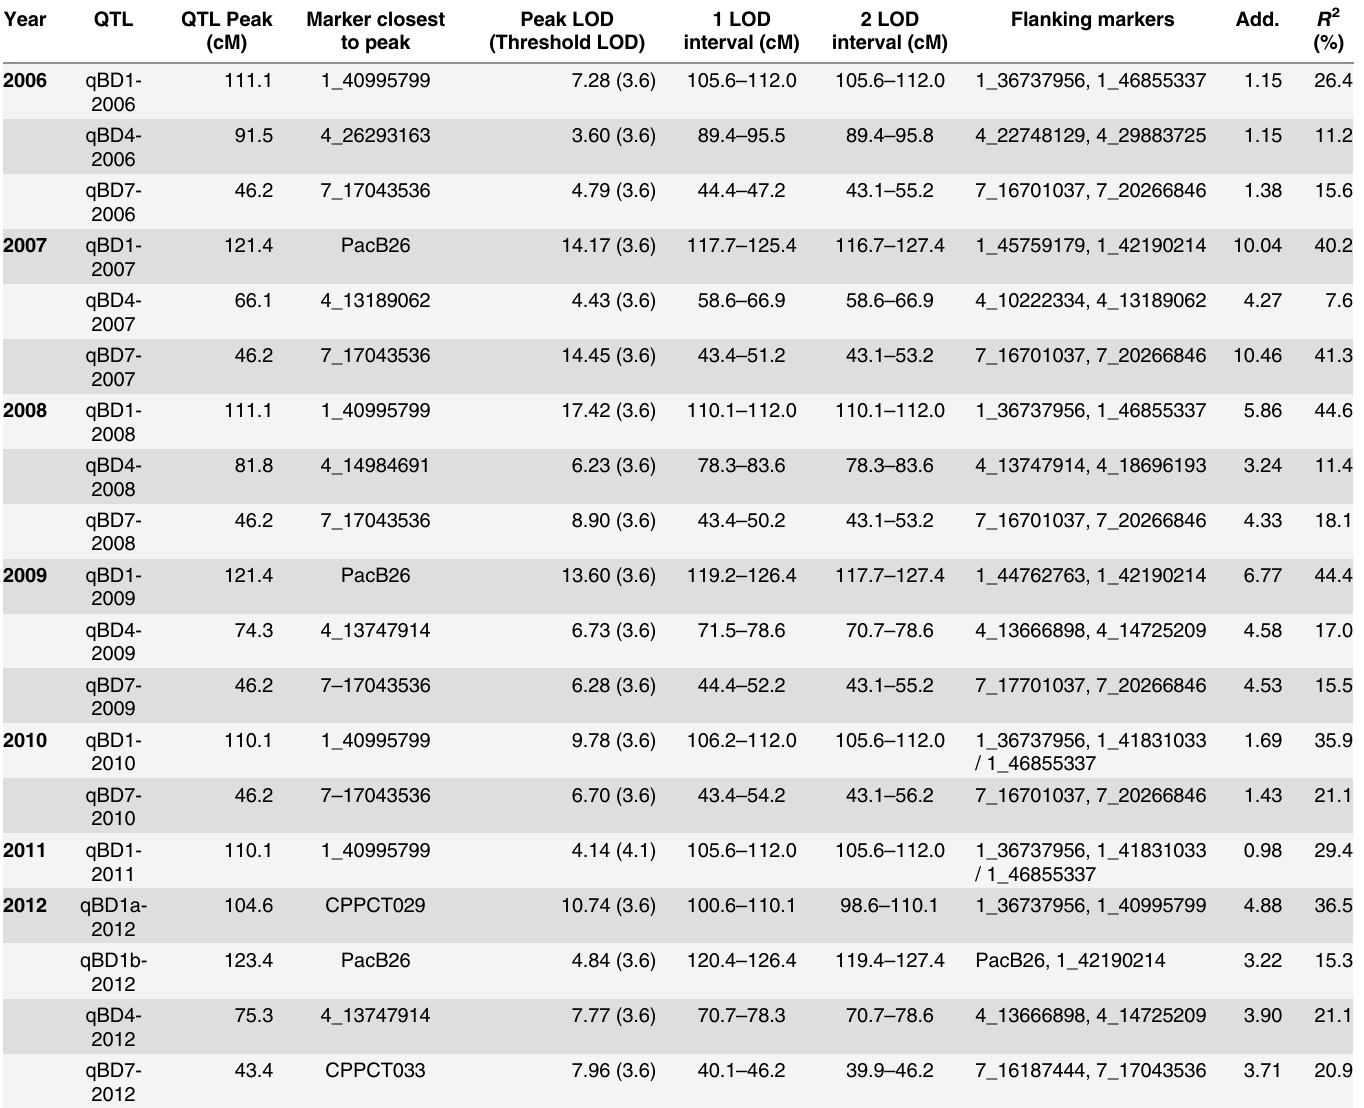
Table 3. Bloom date QTL detected by year from 2006 – 2012. QTL are named as in Table